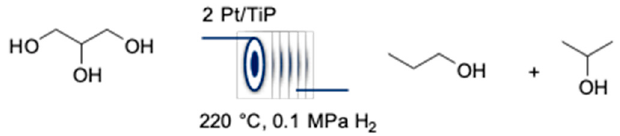
Figure 18. Hydrogenolysis of glycerol to produce 1- and 2-propanols. Table 17. Effect of reaction temperature on glycerol hydrogenolysis over 2Pt/TiP catalyst.